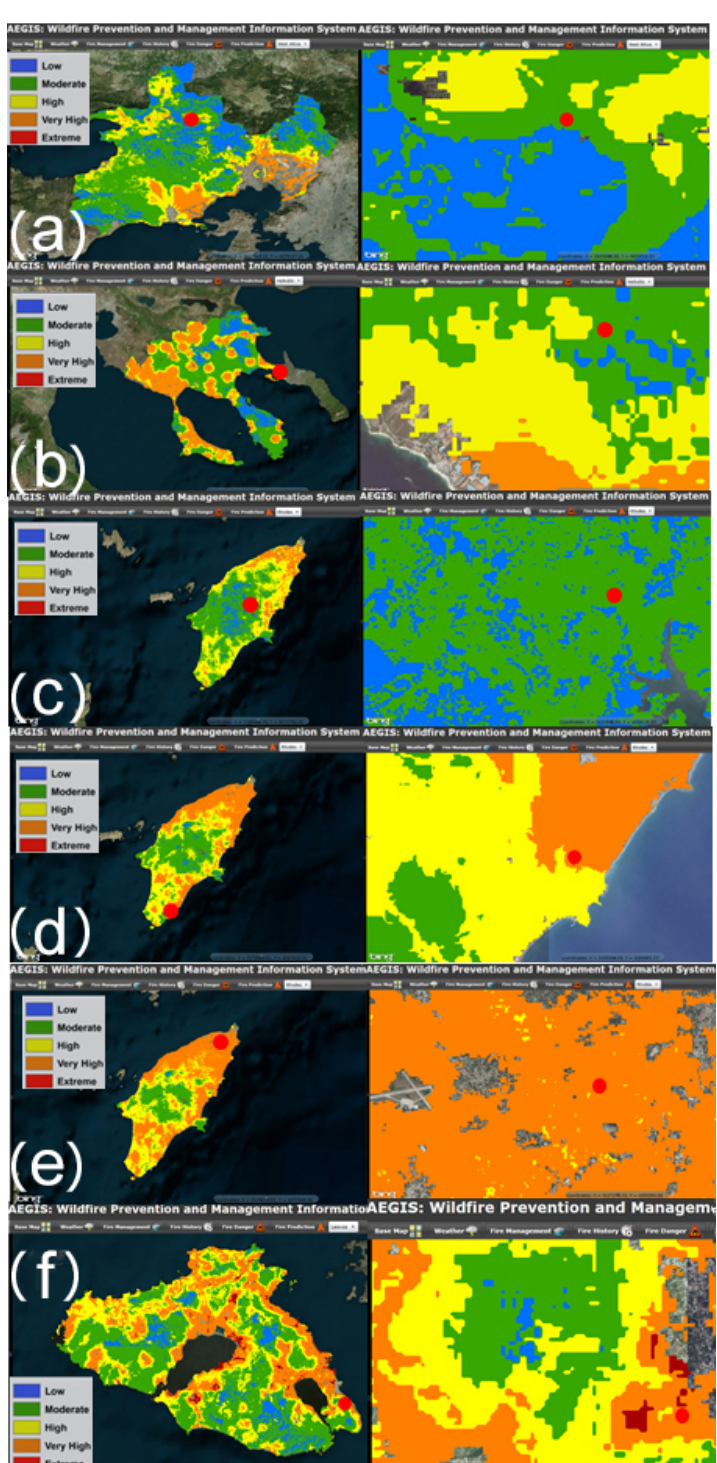
Figure 10. Spatial fire hazard results (left panels) of the six actual wildfires (right panels showing close-up of the starting points as red dots) that occurred during the summer of 2015 in four of our study areas ( a : West Attica, 13 June 2015, 50ha burned; b : Chalkidiki, 16 June 2015, 150ha burned; c : Rhodes, 23 July 2015, 323ha burned; d : Rhodes, 31 July 2015, 50ha burned); e : Rhodes, 23 August 2015, 77ha burned; and f : Lesvos, 30 August 2015, 550ha